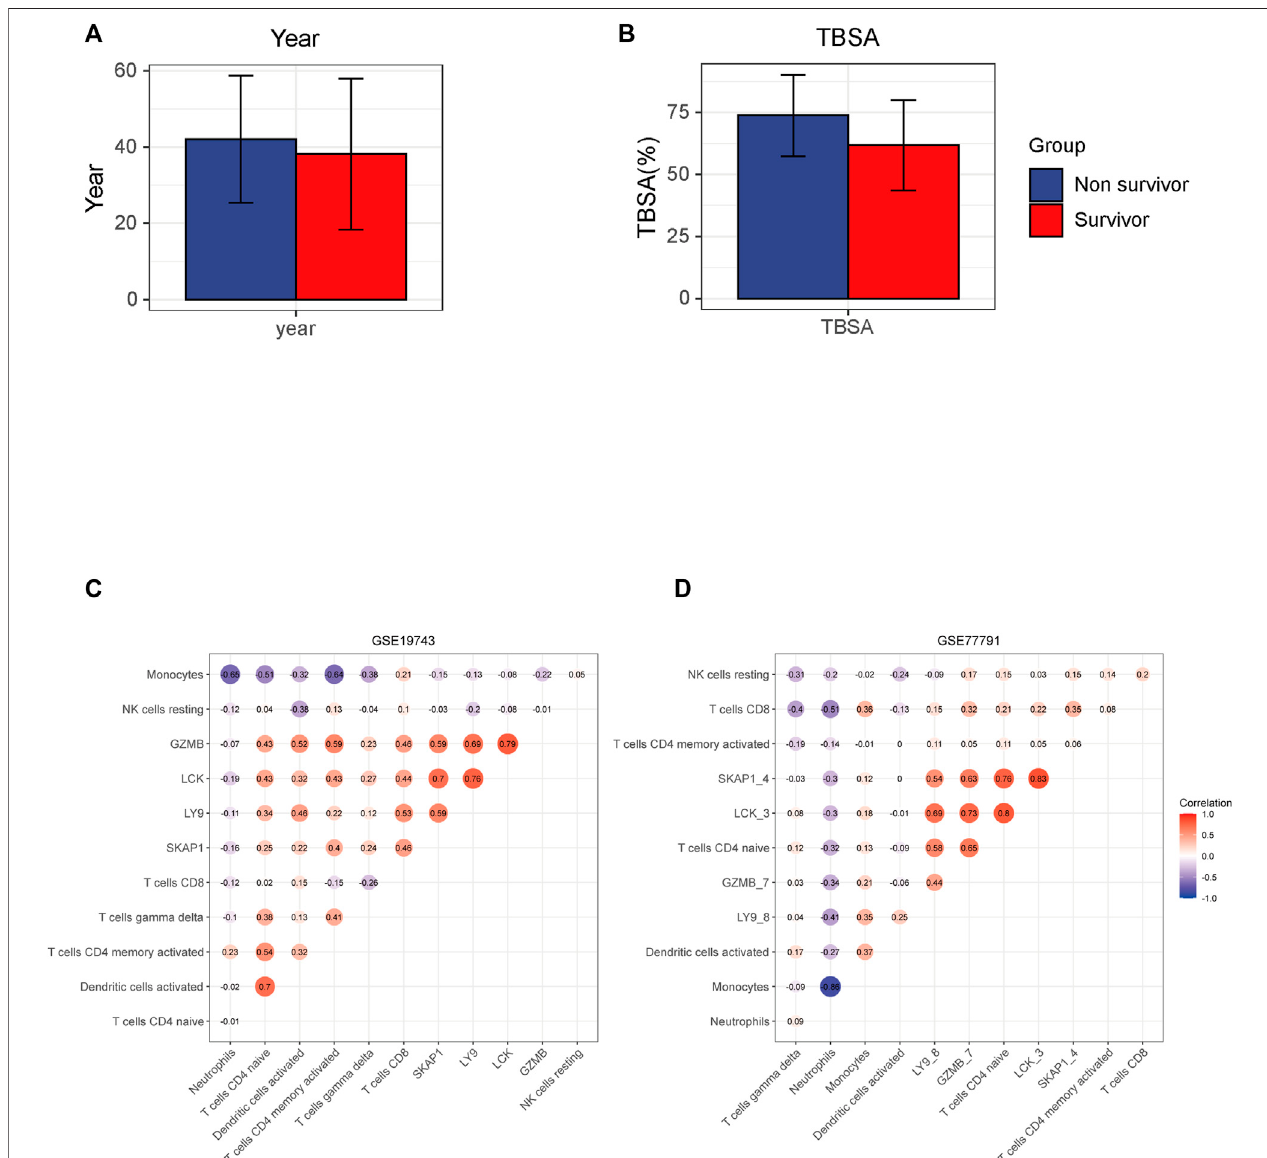
FIGURE 8 | Results of the correlation between key genes and immune cells. (A,B) Different TBSA and years between survival and non-survival patients. Non- survival is older and has a larger TBSA. (C,D) Horizontal and ordinate are the names of the genes and cells. The fi gure in the circle means correlation and red means positive correlation and blue means negative.